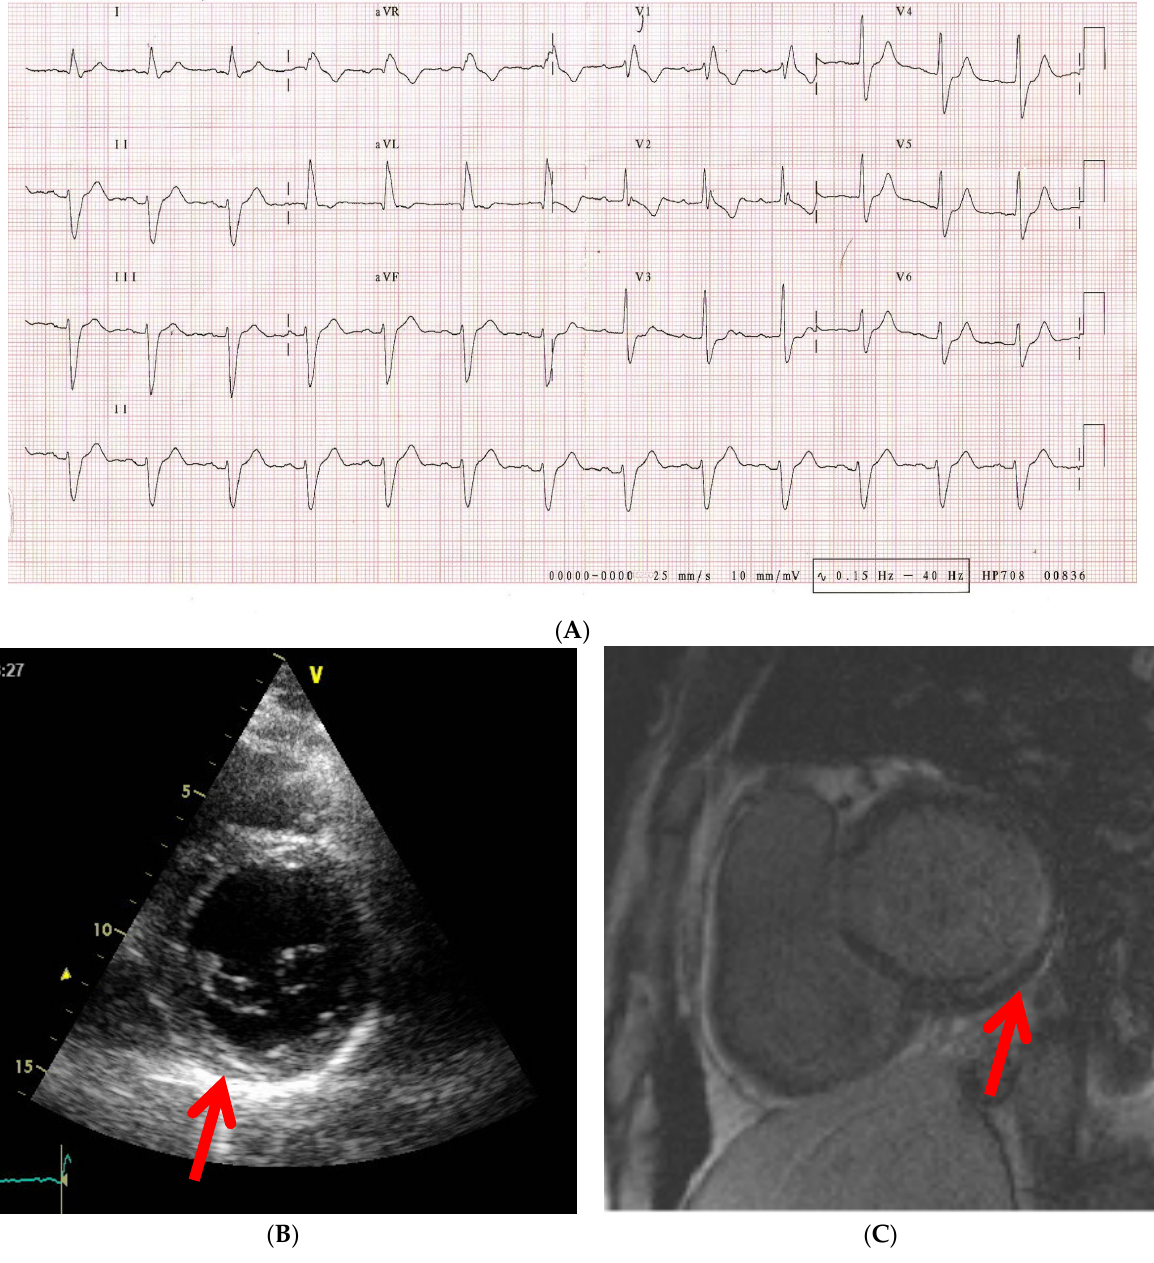
Figure 3. 42 years old male patient diagnosed with dcSSc, normal epicardic coronary arteries. ( A ) ECG tracing with trifascicular block (RBB, AFB, grade 1 AV block), ( B ) 2DTTE PSAX image at the base of the LV showing hyperechogenic area in the infero ‐ basal segment of the LV (red arrow); ( C ) CMR image showing LGE in the infero ‐ basal segment suggestive of subendocardial and mid ‐ wall scar at this level (red arrow). dcSSc, diffuse cutaneous systemic sclerosis; RBB, right bundle branch block; AFB, anterior fascicular block; AV, atrio ‐ ventricular; 2DTTE, two ‐ dimensional transthoracic echocardiography; PSAX, parasternal short ‐ axis view; LV, left ventricle; CMR, cardiac magnetic resonance; LGE, late gadolinium enhancement.